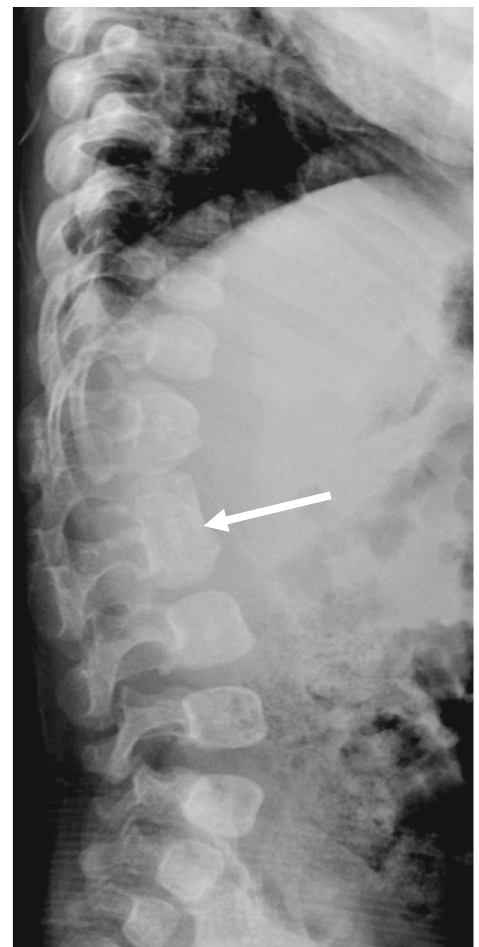
Fig. 10 Ventral block vertebra in 8 month old: Lateral radiograph of the spine demonstrates fused L2 and L3 vertebral bodies ( arrow ). The T12 and L1 vertebral bodies were also partially